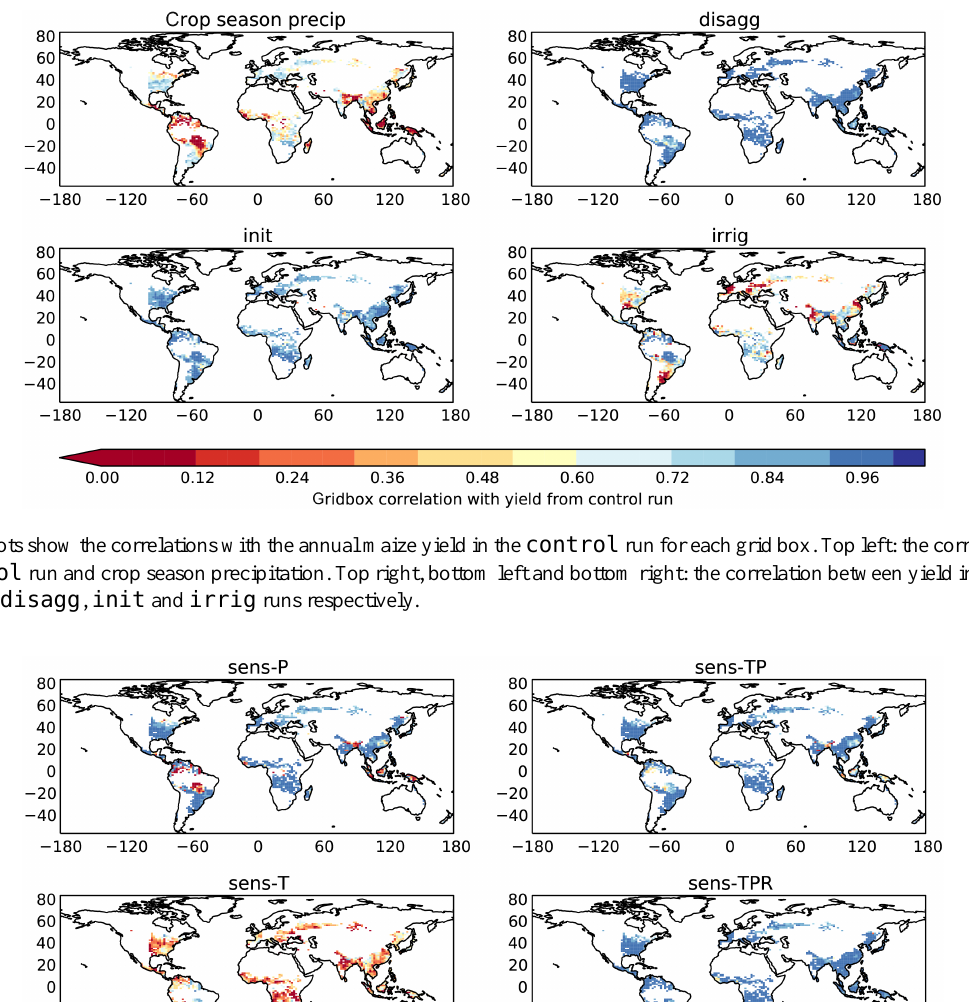
20 % for maize, showing that in most regions soil moisture variability is an import contribution to the yield variability in the control